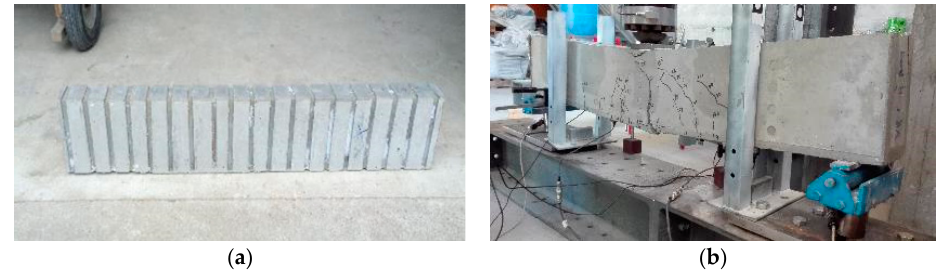
Figure 10. ( a ) Beam with indented surface; ( b ) Beam’s test.